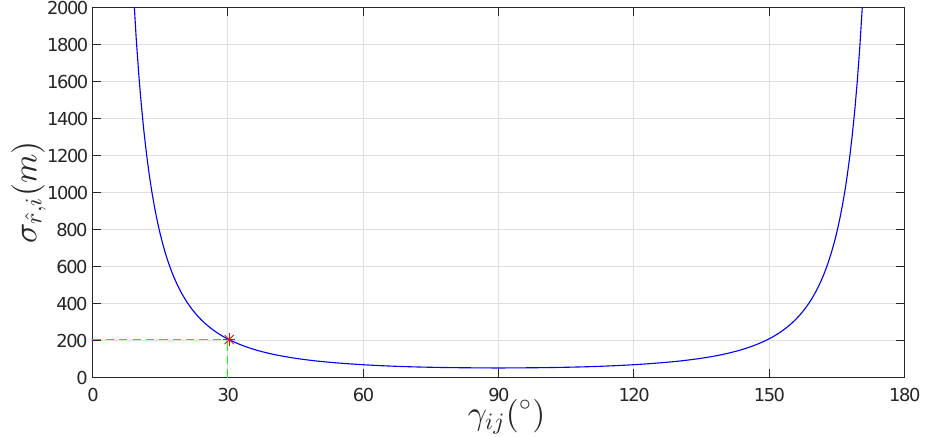
Figure 2. Curve of max ( σ ˆ r ) with γ ij given r ij = 10 km, σ γ = 0.3 ◦